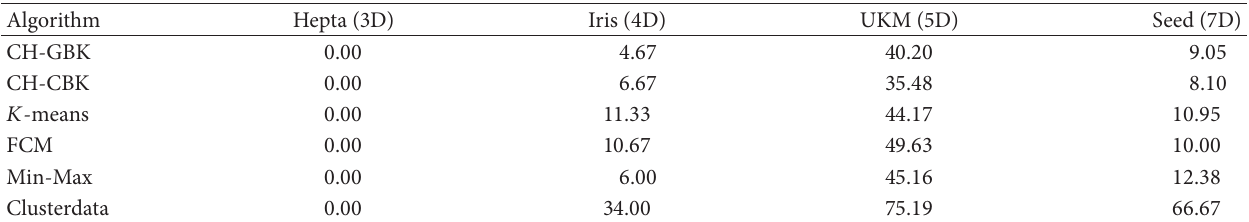
Table 2: Best error rate (%) of pattern assignments obtained over 100 different runs of the